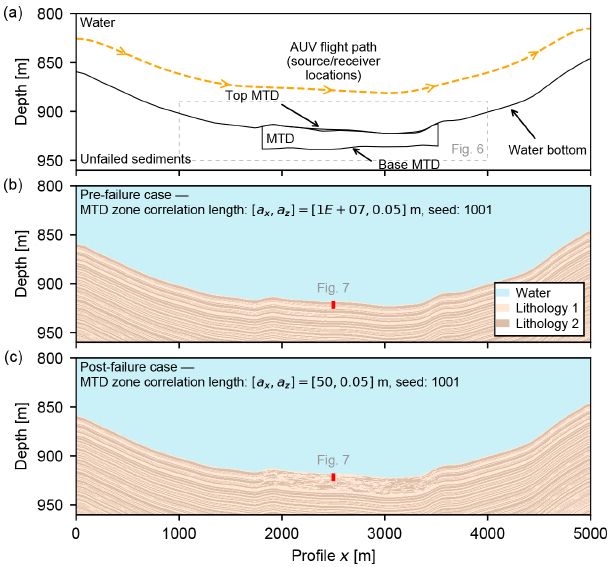
Figure 5. Multi-source synthetic model based on the along-slope AUV sub-bottom profile from the 2017 Black Sea geohazard sur- vey (Fig. 1). (a) Model geometry. The water layer is homoge- neous. The unfailed background sediments and the MTD zone are two-component exponential random media comprising equal parts Lithology 1 and Lithology 2 (see Sect. 3.2 for details of the random fields). Elastic parameters of the component lithologies are listed in Table 1. The source locations along the AUV flight path, approx- imately 40m above the water bottom, are marked by the dashed yellow line (source interval 2m). Two realisations of the model with the same random seed are shown: (b) MTD zone in pre-failure state (lateral correlation length is equivalent to unfailed sediments, a x = 10 7 m), (c) MTD zone in post-failure state (shorter lateral cor- relation length, a x = 50m). The location and extent of the synthetic sediment core in Fig. 7 are shown in red. “MTD” corresponds to mass-transport deposit.